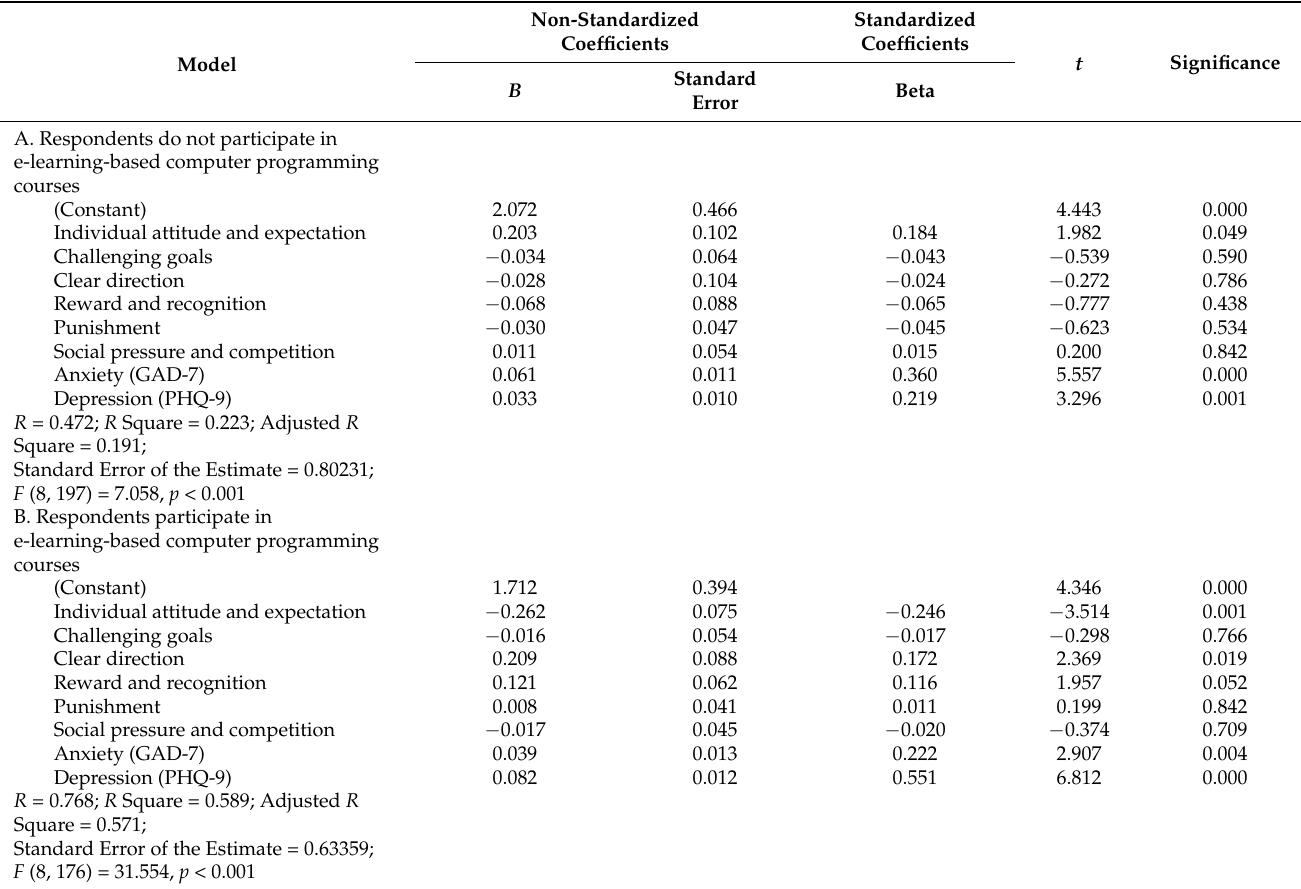
Table 13. Multiple regression models in which the dependent variable is general fatigue and the predictors are learning motivating factors, anxiety, and